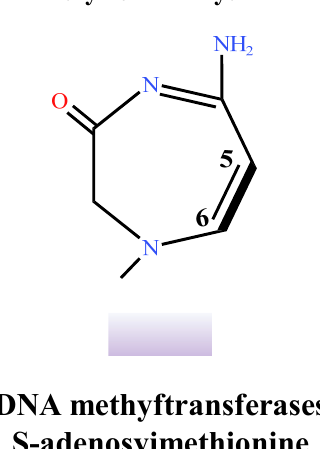
DNA methyftransferases